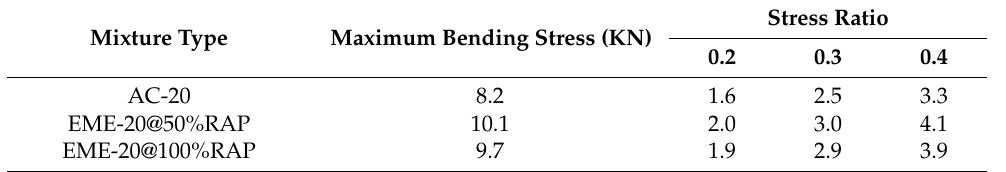
Table 8. Bending stress of specimens of different